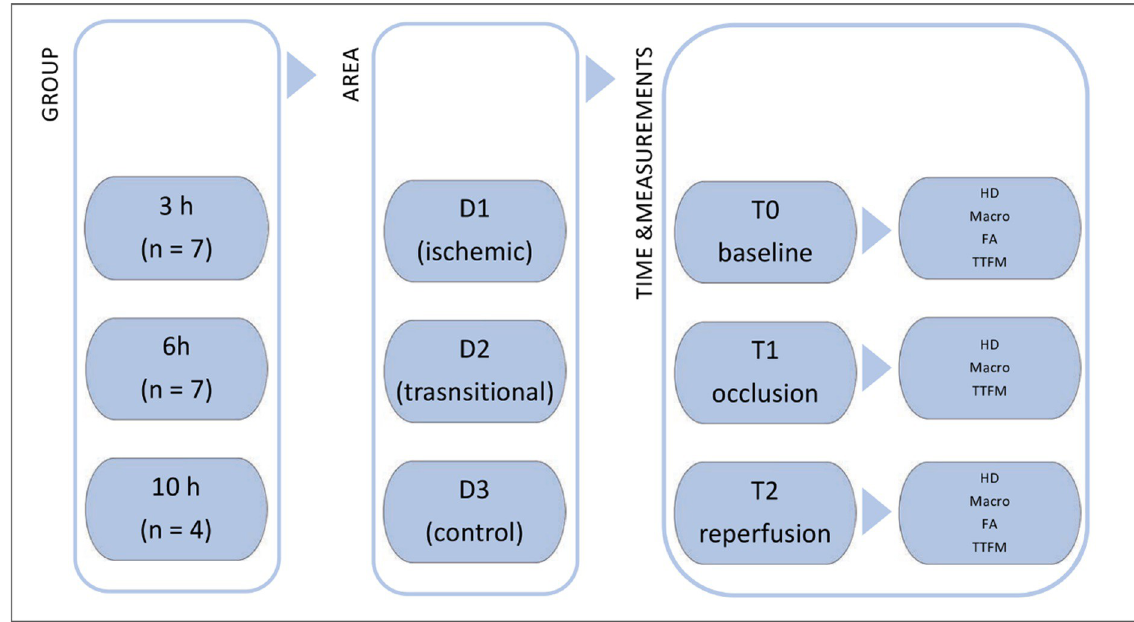
Fig 2. Experimental setting. This figure shows the simplified experimental set up. In each group different ischemic durations were studied. Number of animals are shown in the brackets. In each animal different areas were defined in order to their perfusion status. In each area, the measurements were carried out at the three time points T0-T1. h: hours of ischemia;n: number of individuals; D1: ischemic area; D2: transsitional area; D3: control area; T0: baseline;T1:occlusion;T2:reperfusion; HD:hemodynamics;Macro: macroscopic score; FI: Fluorescent Imaging; TTFM: Transit Time Flow Measurement in Superior Mesenteric